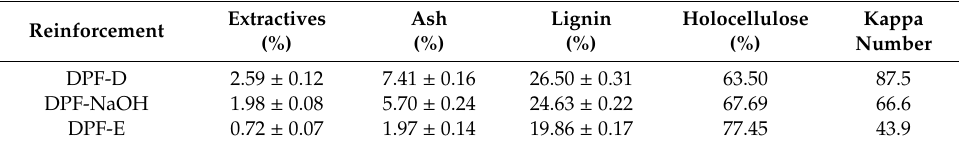
Table 2. Chemical composition of the obtained DPF.